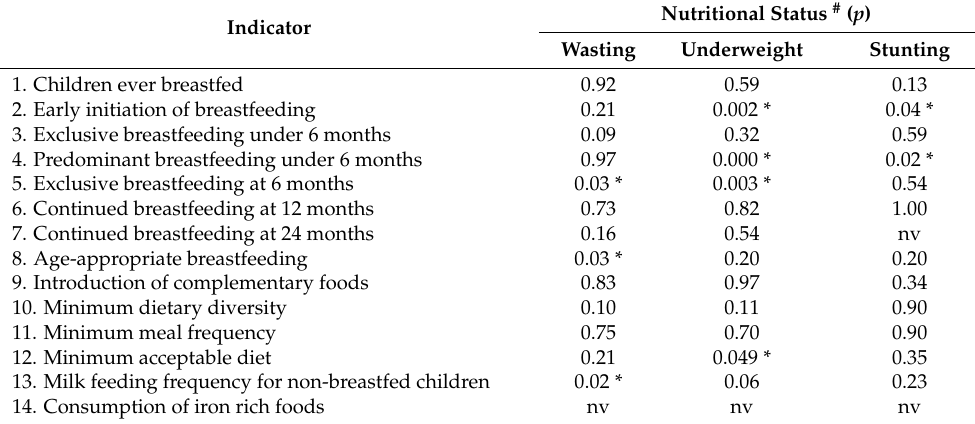
Table 3. Association between breastfeeding or complementary feeding indicators (WHO, 2010) and malnutrition, in 278 infants and young children seen at the Klinik Saint Espri Health Center, Port au Prince, Haiti (August